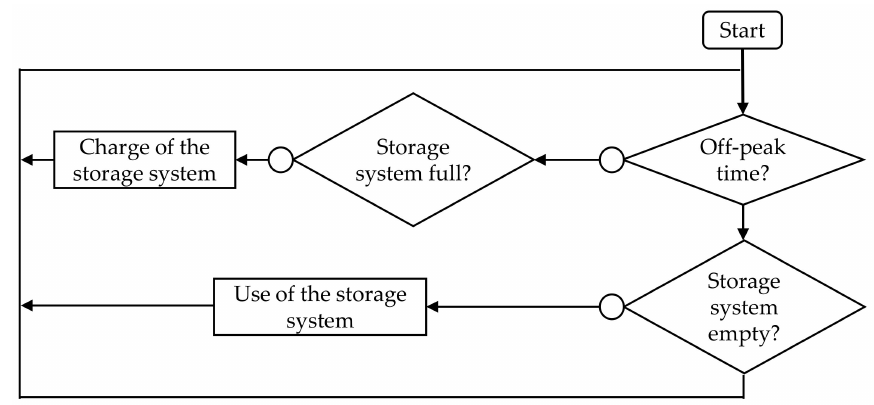
Figure 16. Flowchart of a basic HEMS without any STLF algorithm [38].